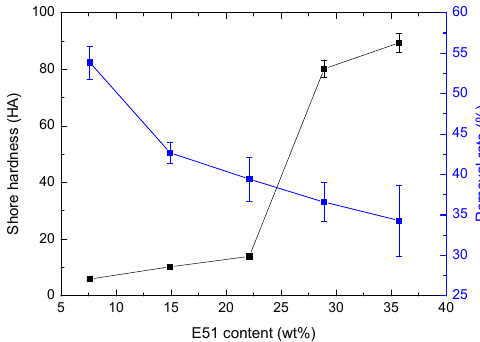
Figure 11. Shore’s hardness and bacterial removal rate with E51 content.